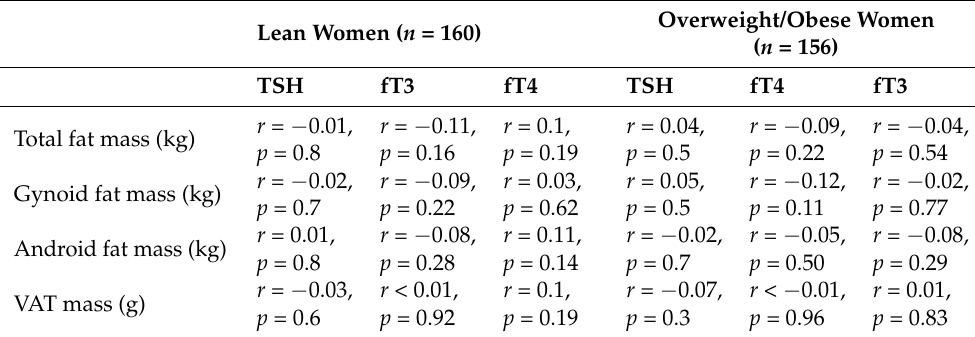
Table 3. Relationships between serum TSH, fT4, and fT3 concentrations and body composition parameters estimated with DXA in lean and overweight/obese